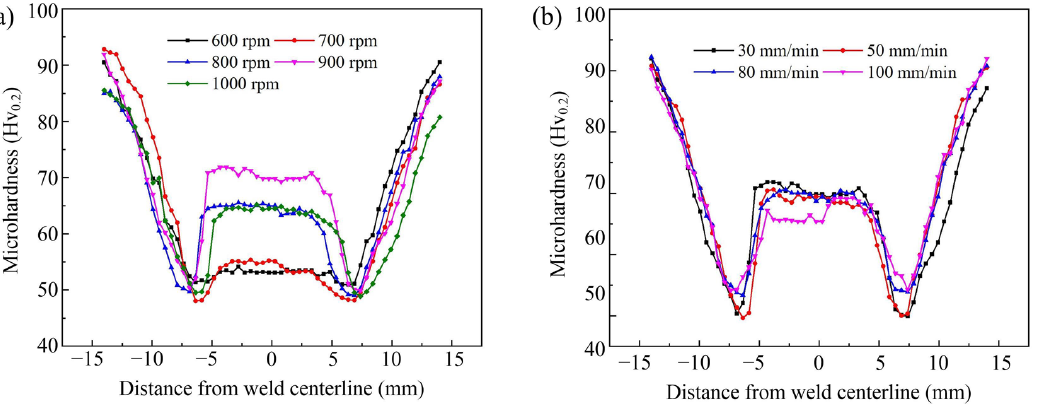
Figure 14. Microhardness distribution on the transverse cross-section of the joint: ( a ) variation with rotation speeds, v = 30 mm/min; ( b ) variation with welding speeds, ω = 900 rpm; ( d = 12 mm).